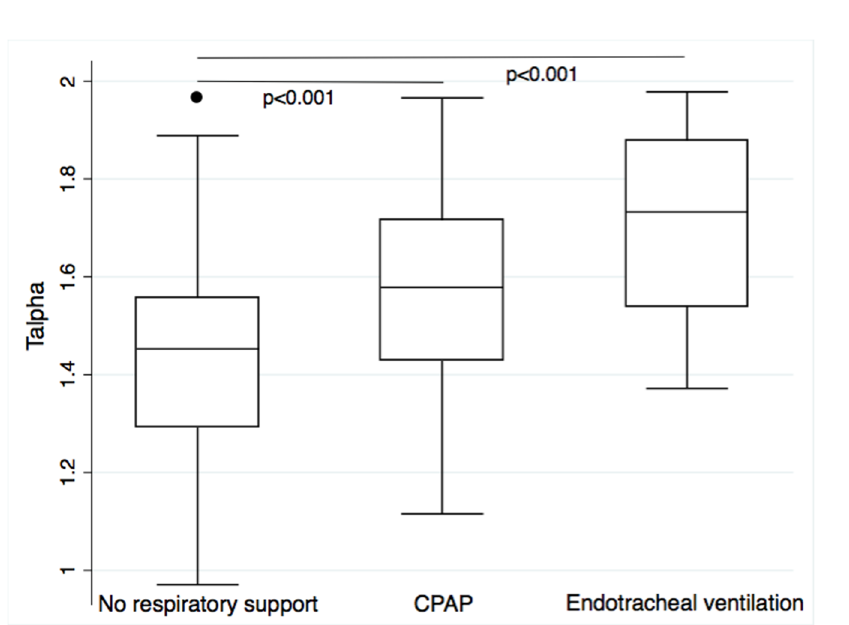
Fig 3. Scaling exponent alpha (T alpha ) over respiratory support. T alpha groupedby the level of respiratory support present duringa temperature measurement. Multilevellinear regressionanalysisdemonstrated a significantpositive associationbetweenT alpha and stepwise increaseof respiratory support from none to continuous positive airway pressure (CPAP), and from CPAP to endotrachealventilation (p < 0.001, R 2 =